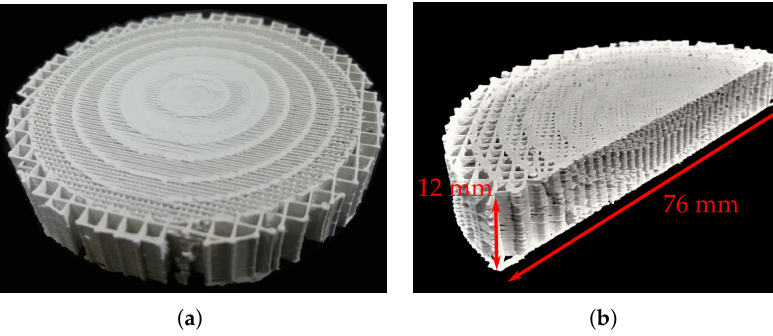
Figure 7. 3D-printed transformed hyperbolic flat lens. ( a ) 3D-printed prototype. ( b ) Cut-view over the 3D-printed transformation